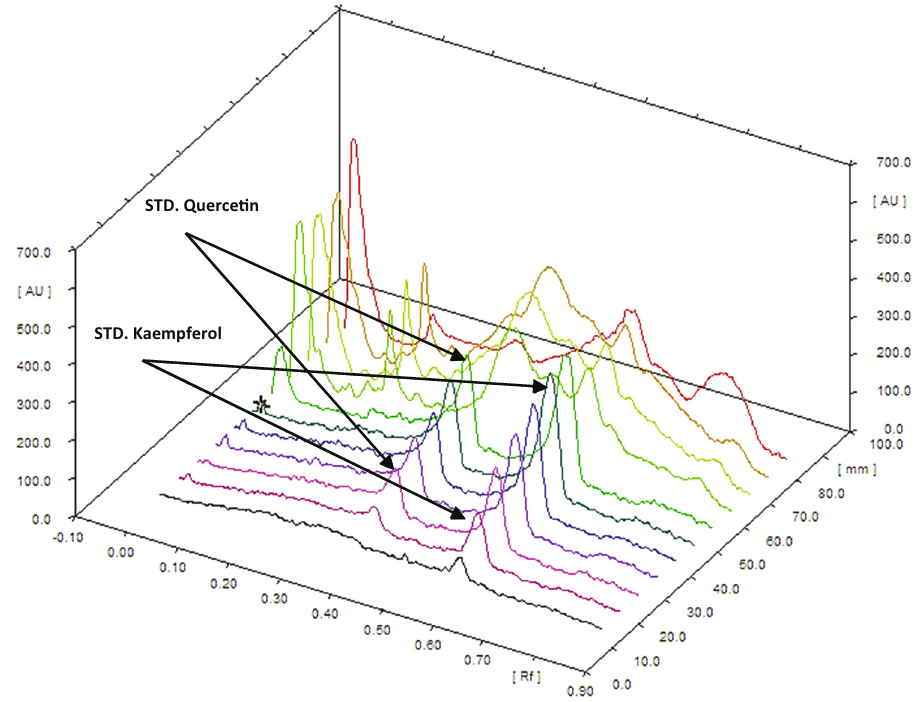
Figure 6: Three - dimensional chromatogram displays all tracks of rutin and DVME.